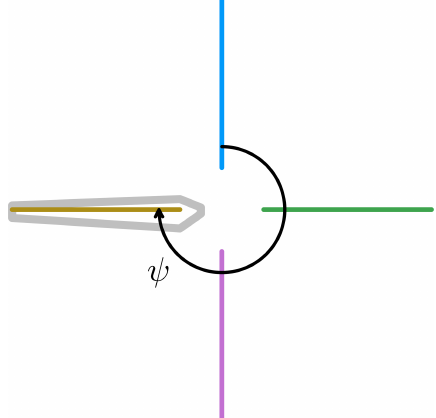
Figure 15. Amplitude of blade thrust coefficient fluctuation for various side wind angles and various maximum side wind angles achieved during sway motion. Thrust normalized with maximum rotor velocity magnitude.